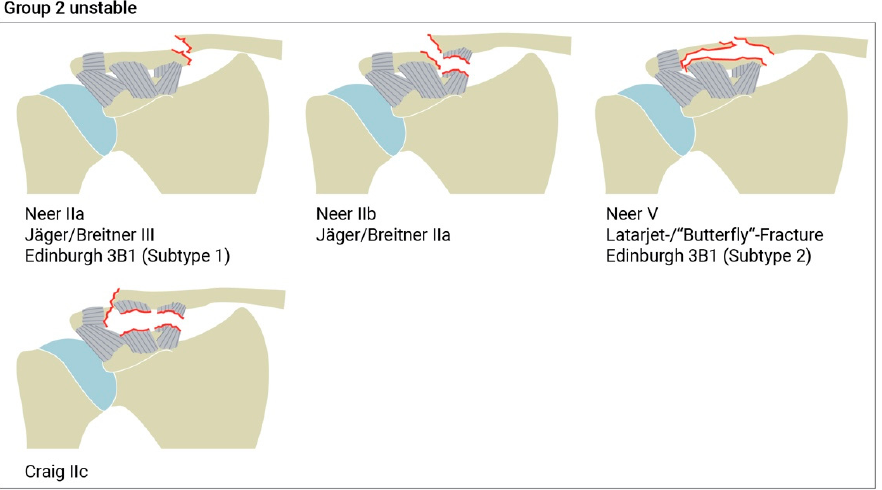
Figure 1. Overview of fracture classifications at the distal clavicle used in this study. The upper section of the graphic shows the stable fracture types and the lower part shows the unstable ones.